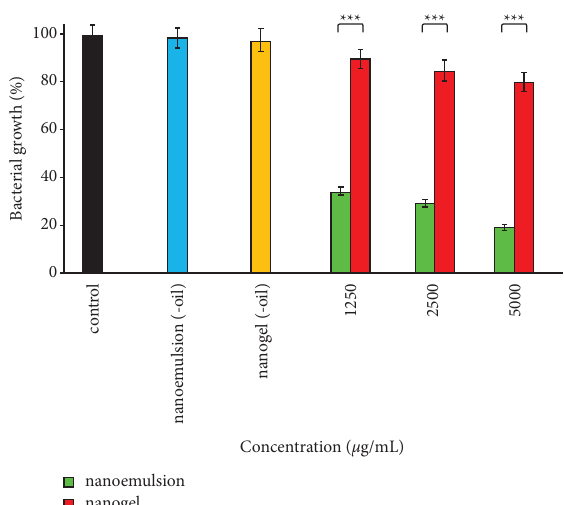
Figure 7: Antibacterial impacts of the nanoemulsion and nanogel containing C . cyminum EO against S . aureus ; ∗∗∗ P < 0 . 001.